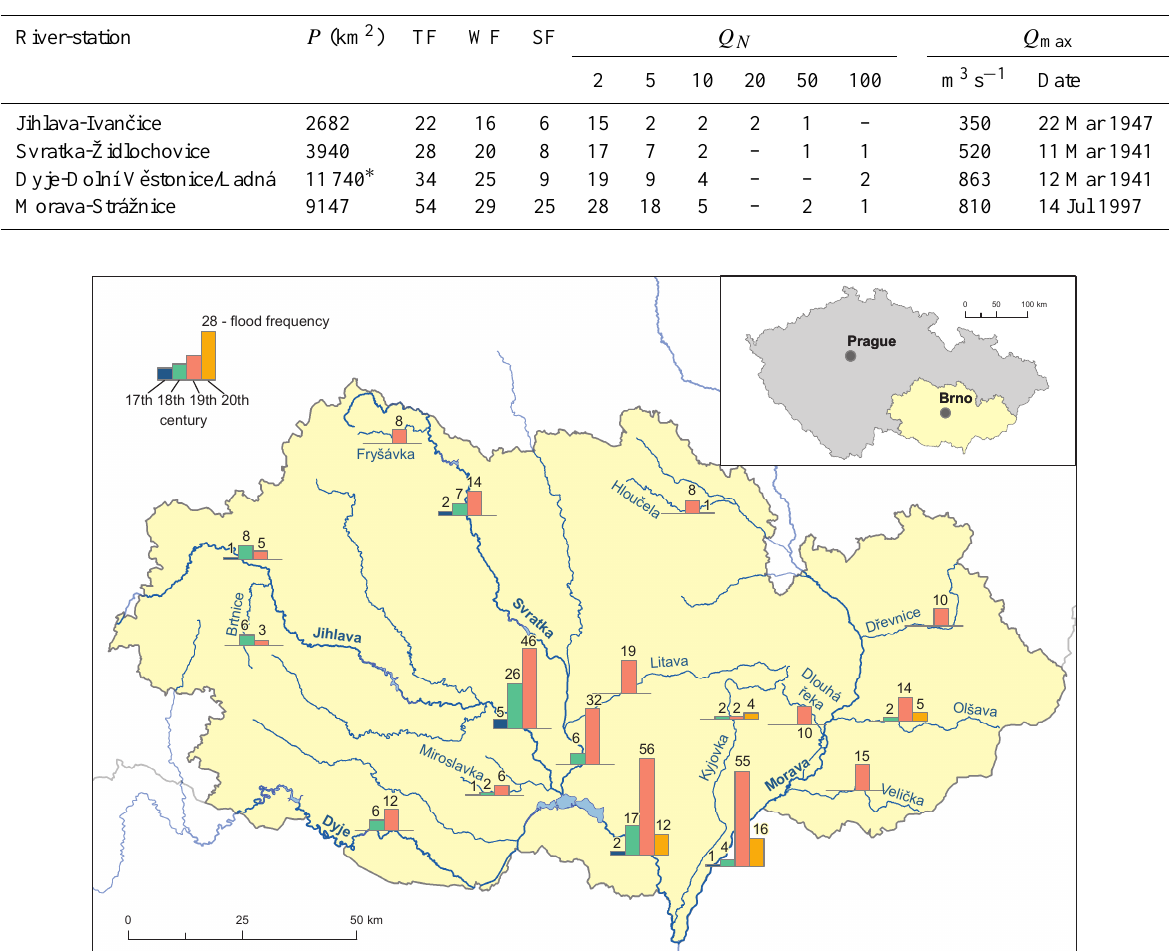
Figure 5. The numbers of floods detected in taxation records and attributed to individual rivers or their parts in South Moravia by the century, from the 17th to the